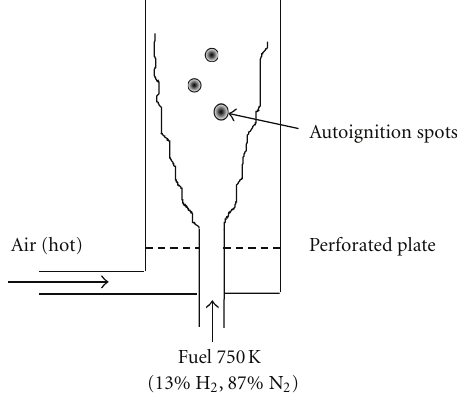
Figure 2: Schematic of the experimental setup [4].